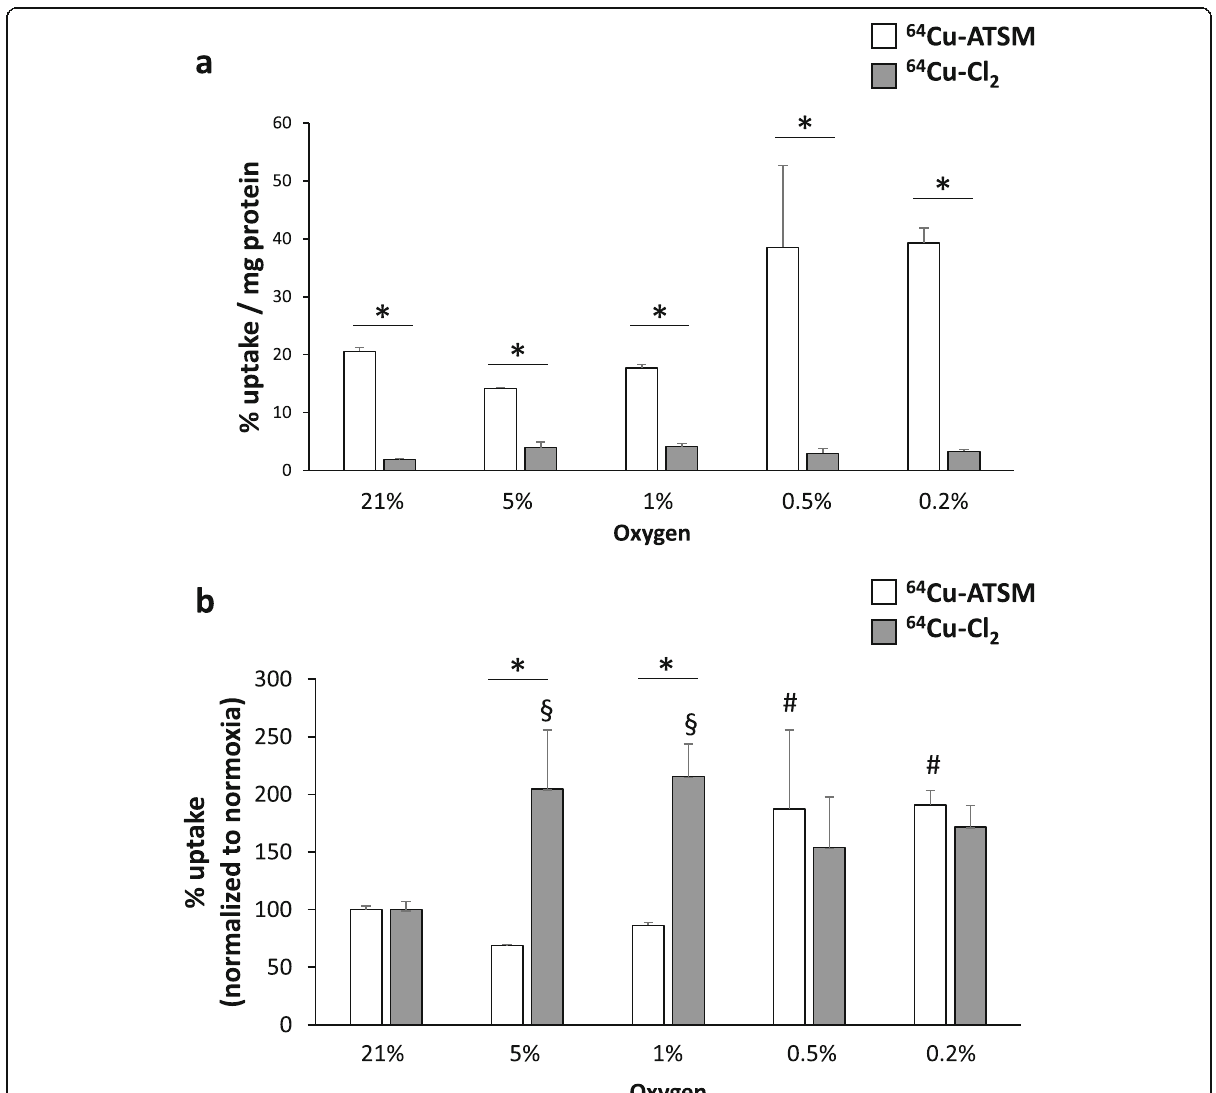
Fig. 2 In vitro uptake of 64 Cu-ATSM and 64 Cu-Cl 2 in tumor cells as a function of the degree of oxygenation. Quantification of cell retention of 64 Cu-ATSM or 64 Cu-Cl 2 in normoxic (21% O 2 ), moderate hypoxia (5% and 21% O 2 ), or severe hypoxia (0.5% and 0.2% O 2 ) for raw values ( a ) or normalized values relative to normoxic condition ( b ). Mean ± SD, n = 3 different cell cultures per condition. Tukey ’ s HSD test after significant two- ways ANOVA (group and time factors) was used. For comparison between 64 Cu-ATSM and 64 Cu-Cl 2 for each oxygen condition, statistical significance was * p < 0.05. Statistical significances relative to normoxia were § < 0.05 for 64 Cu-ATSM and # p < 0.05 for 64 Cu-Cl